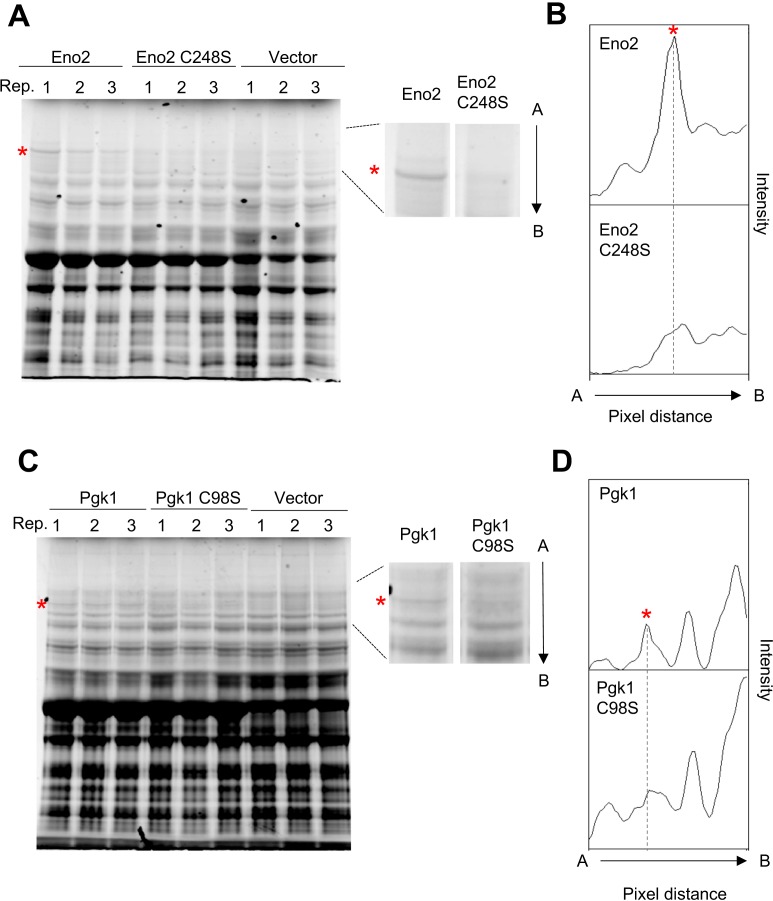
Aggregation of Eno2 and Pgk1 requires cysteine residues in Eno2 and Pgk1.(A and C) SDS-PAGE-separated total proteins of cells overexpressing the indicated proteins. Three biological replicates for each experiment are shown. C248S: substitution of cysteine 248 to serine; C98S: substitution of cysteine 98 to serine. The arrow from A to B indicates the direction of the pixel intensity analysis shown in (B) and (D). (B and D) The pixel intensity analysis of the gel corresponding to the location containing the protein aggregate shown as the arrow between A and B. Image Quant TL software was used for the image analysis. The asterisk indicates the high-molecular-weight band specifically observed upon overexpression of each glycolytic protein.